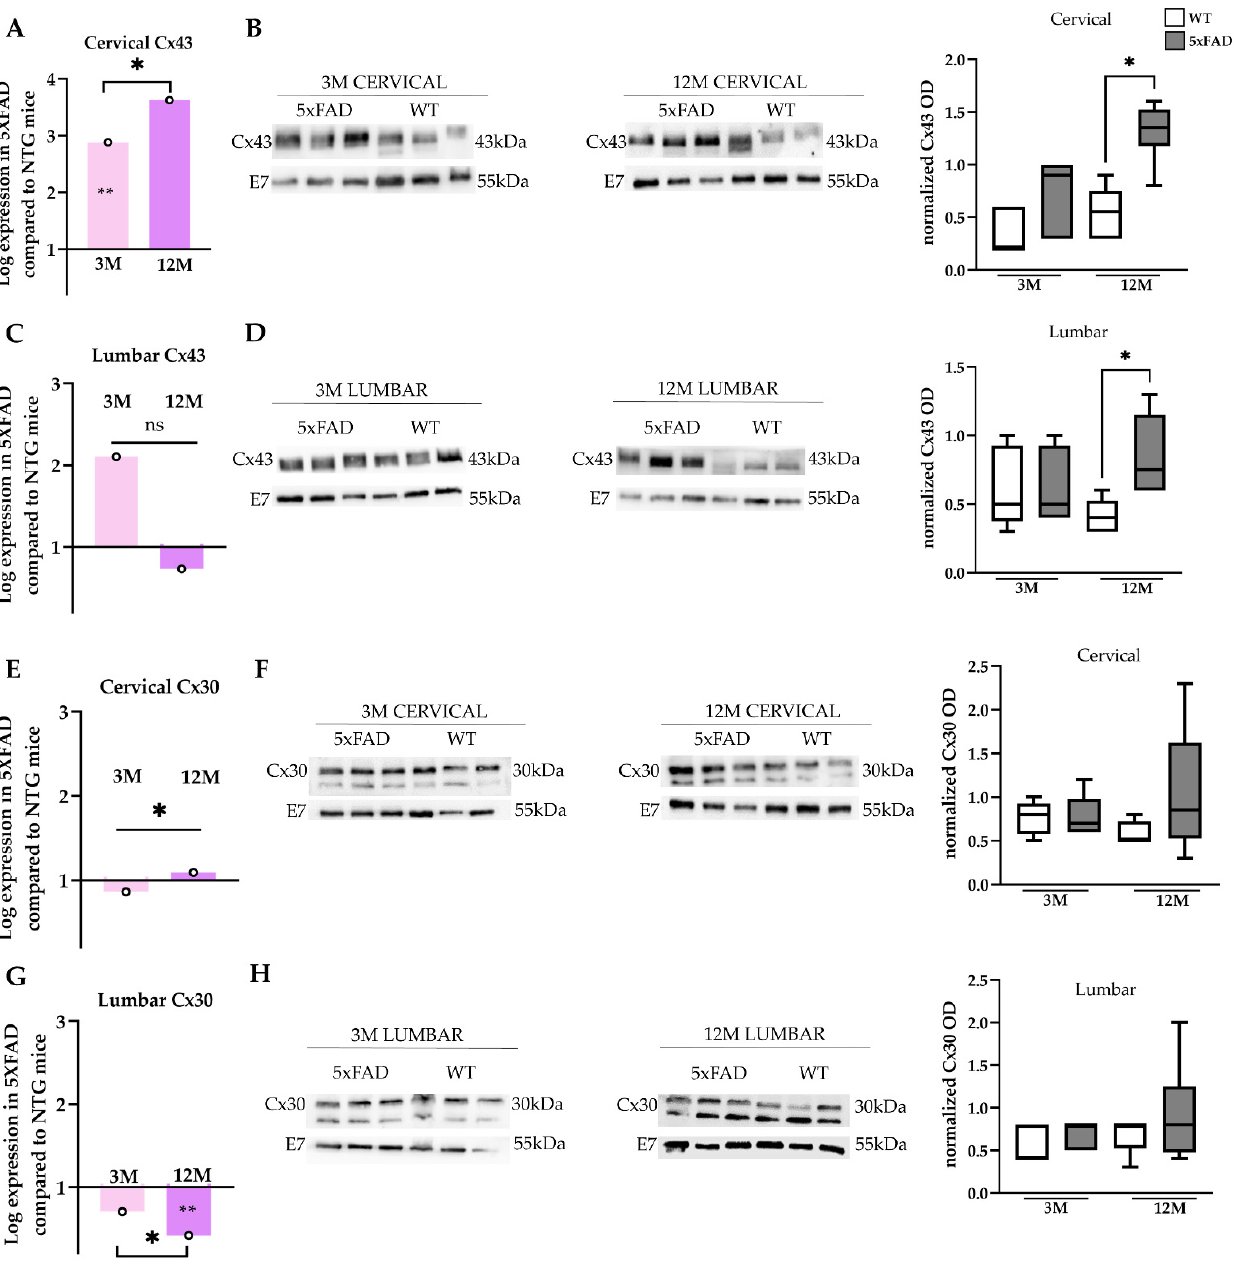
Figure 6. Cx43 and Cx30 mRNA and protein levels in the spinal cord of 5xFAD mice. RT-PCR analysis of Cx43 ( A , C ) and Cx30 ( E , G ) mRNA transcript levels in the cervical and lumbar spinal cord tissue of 3- and 12-month-old 5xFAD and WT mice. The asterisks inside the columns of the mRNA graphs denote the p -values representing significance of connexin levels in 5xFAD compared with WT controls, while the asterisks outside the columns show the significance between different age groups of 5xFAD mice. Quantification of normalized band optic density (OD) revealed increased Cx43 protein levels ( B , D ) and unchanged Cx30 protein levels ( F , H ) in 12M 5xFAD mice compared with the WT controls at both spinal cord levels. β -Tubulin was used as an internal control for the mRNA analysis and as a loading control for the immunoblot analysis (E7). Statistical analysis for the mRNA was performed by unpaired t -test ( n = 6 for all genotype and age groups) and for the immunoblots was performed by one-way ANOVA followed by Kruskal–Wallis multiple comparisons test ( n = 6 for all genotype and age groups). Data are presented as mean ± SD. Significance is given as: * p < 0.05, ** p <